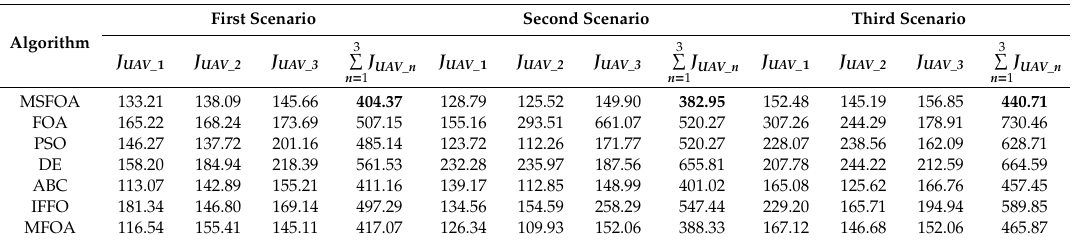
Table 2. The objective function of each UAV obtained by various algorithms in the three scenarios.